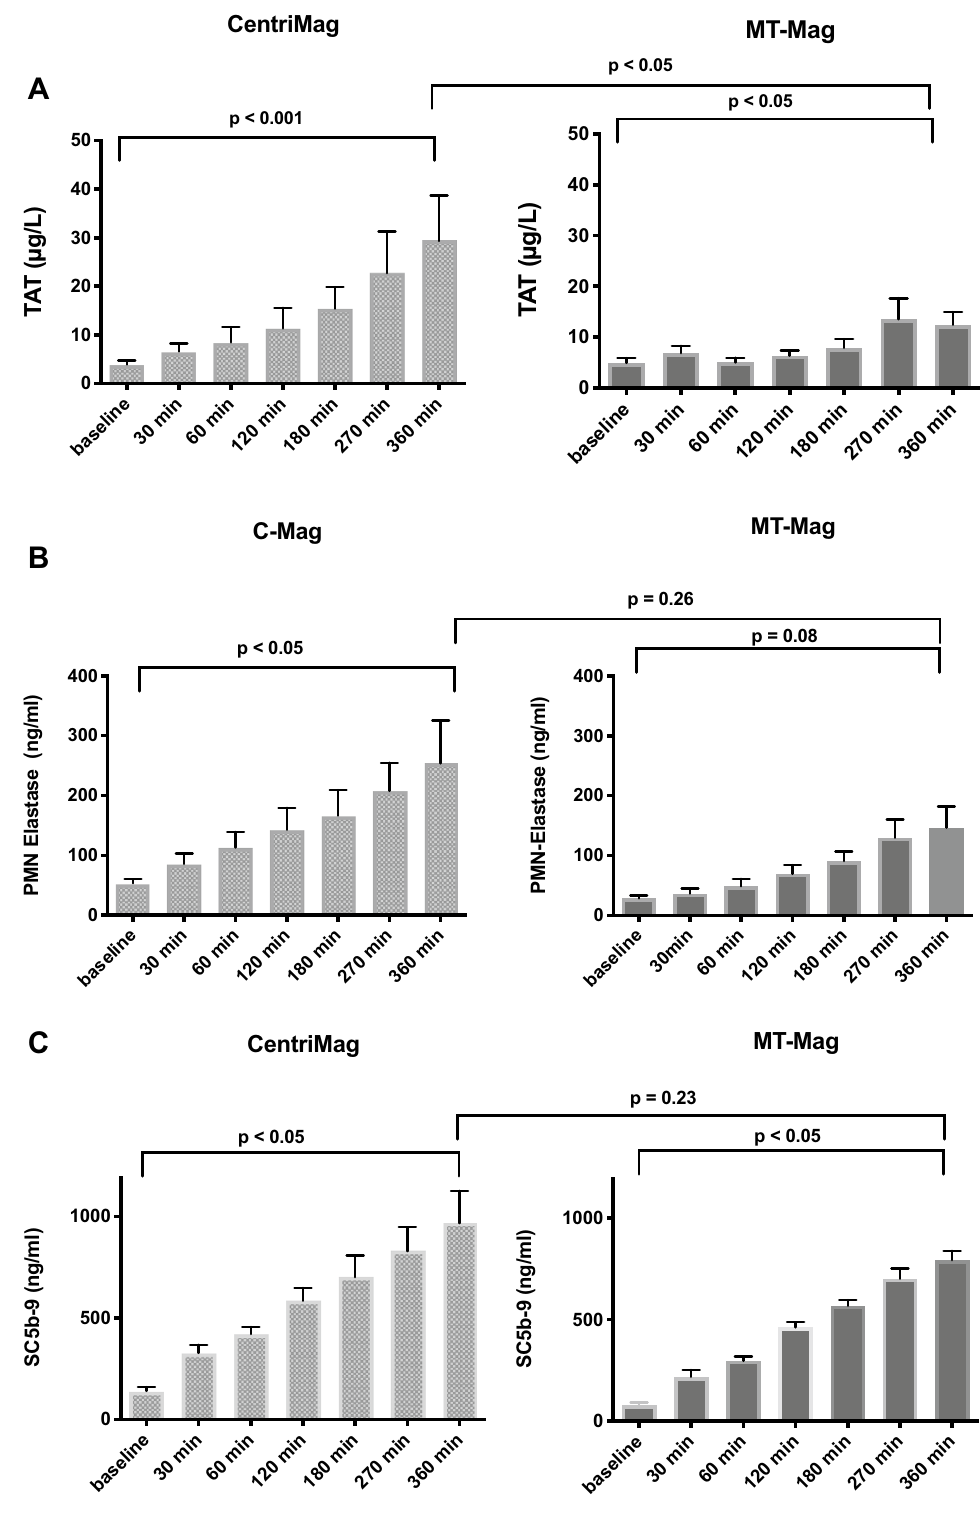
Figure 3. (A) ELISA quantification of thrombin–antithrombin III complex (TAT) as a marker of coagulation activation. Both groups revealed a significant increase of up to 360 min during the experiment. TAT values were higher in the C-Mag group than the MT-Mag group (29.4 ± 5.4 µg/L vs. 12.5 ± 2.5 µg/L, p < 0.05). (B) ELISA quantification of blood levels of polymorphonuclear (PMN)-elastase as an inflammation marker. C-Mag and MT-Mag group PMN values were comparable (162.2 ± 58.2 ng/mL vs. 253.8 ± 71.5 ng/mL, p < 0.26) after 360 min. (C) Blood levels of SC5b-9 as a key element within the complement cascade detected by ELISA. After 360 min both groups ‘ values were comparable (967.9 ± 158.2 ng/mL vs. 793.2 ± 74.4 ng/mL ng/mL, p =